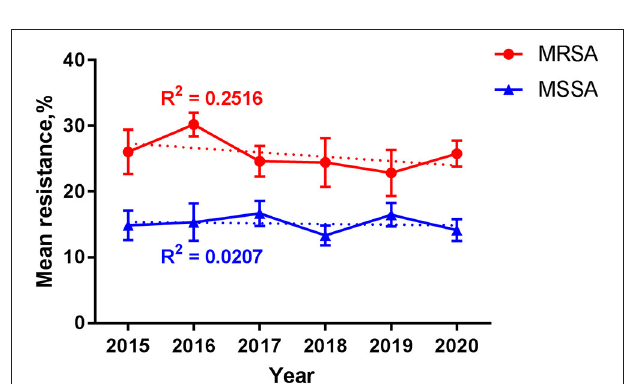
FIGURE 6 | Resistance among S. aureus over time. Data are presented as mean (standard error) percentage of resistance for MRSA (red line) and MSSA (blue line) by year. Trend lines are shown as the dotted ones, with the correlation coefficient R 2 = 0.2516 and 0.0207 for MRSA and MSSA, respectively. MRSA, methicillin-resistant S. aureus ; MSSA, methicillin-sensitive S. aureus .